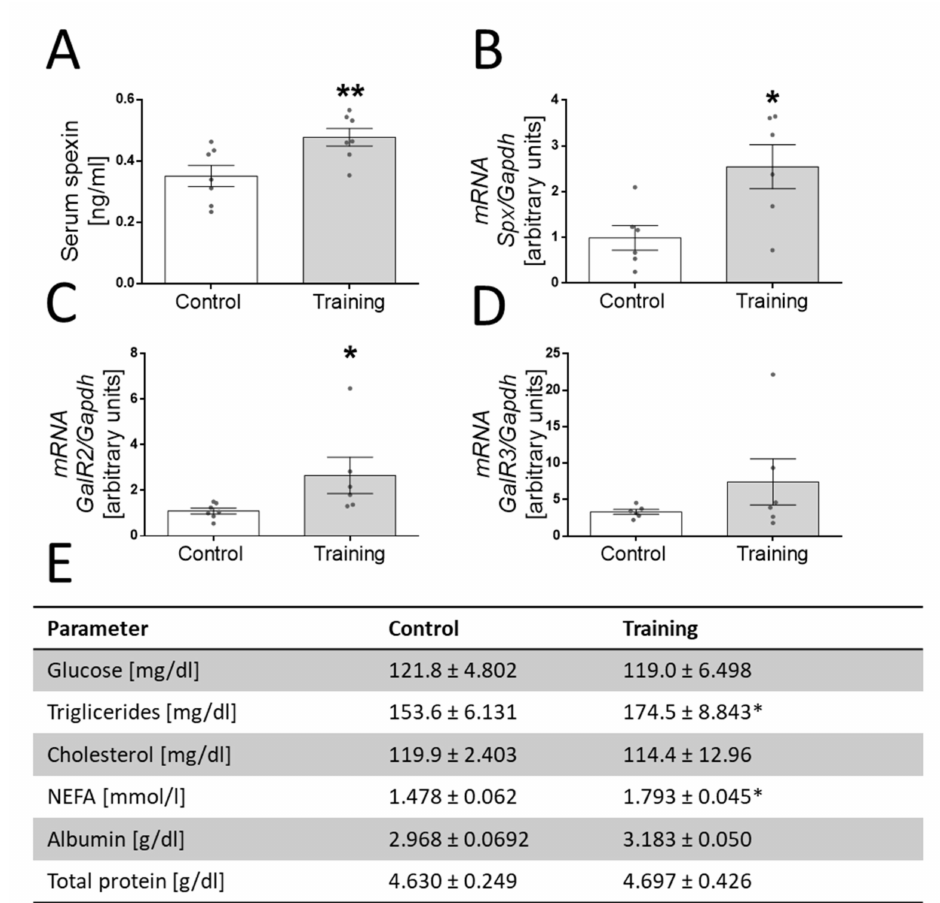
Figure 6. The effect of exercise on spexin concentration in blood serum in mice ( A ), SPX ( B ), GalR2 ( C ) and GalR3 ( D ) mRNA levels in skeletal muscle. The effect of exercise on basic biochemical parameters of blood in the mice subjected to the study ( E ) ( n = 6, 7 per group). Statistically significant differences are marked for p < 0.05 (*) and p < 0.01 (**) compared to the